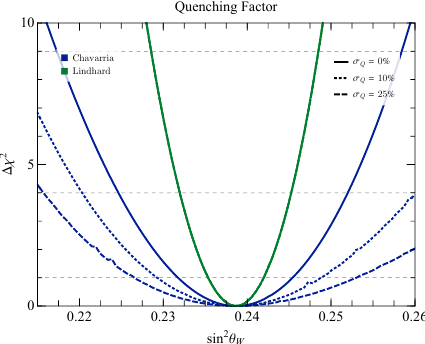
Figure 3 . Benchmark sensitivity to sin 2 θ W for Lindhard (green) and Chavarria (dark blue) quench- ing factor models, for systematic uncertainties of 0% (solid), 10% (dotted) and 25% (dashed). We indicate 1 σ , 2 σ , and 3 σ precision ( ∆ χ 2 = 1 , 4 , 9 ) by the gray dashed horizontal